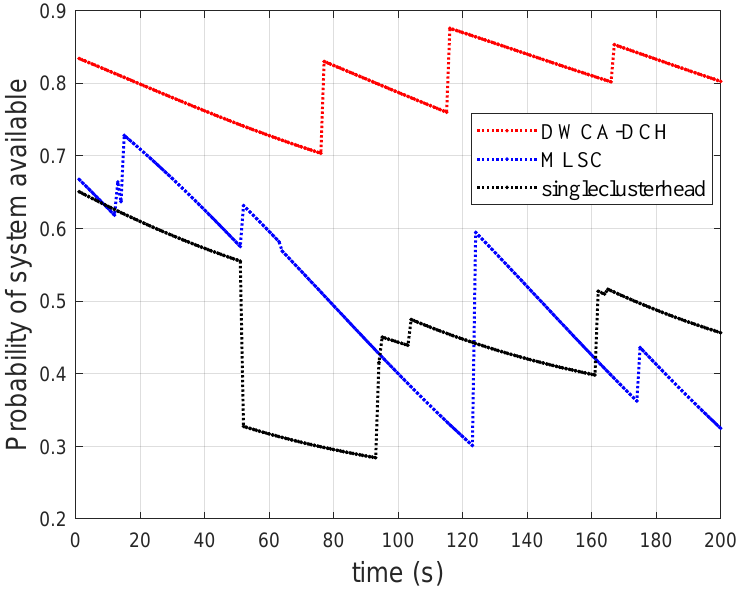
Figure 10. The variation trend of system of available probability as t increases compared with